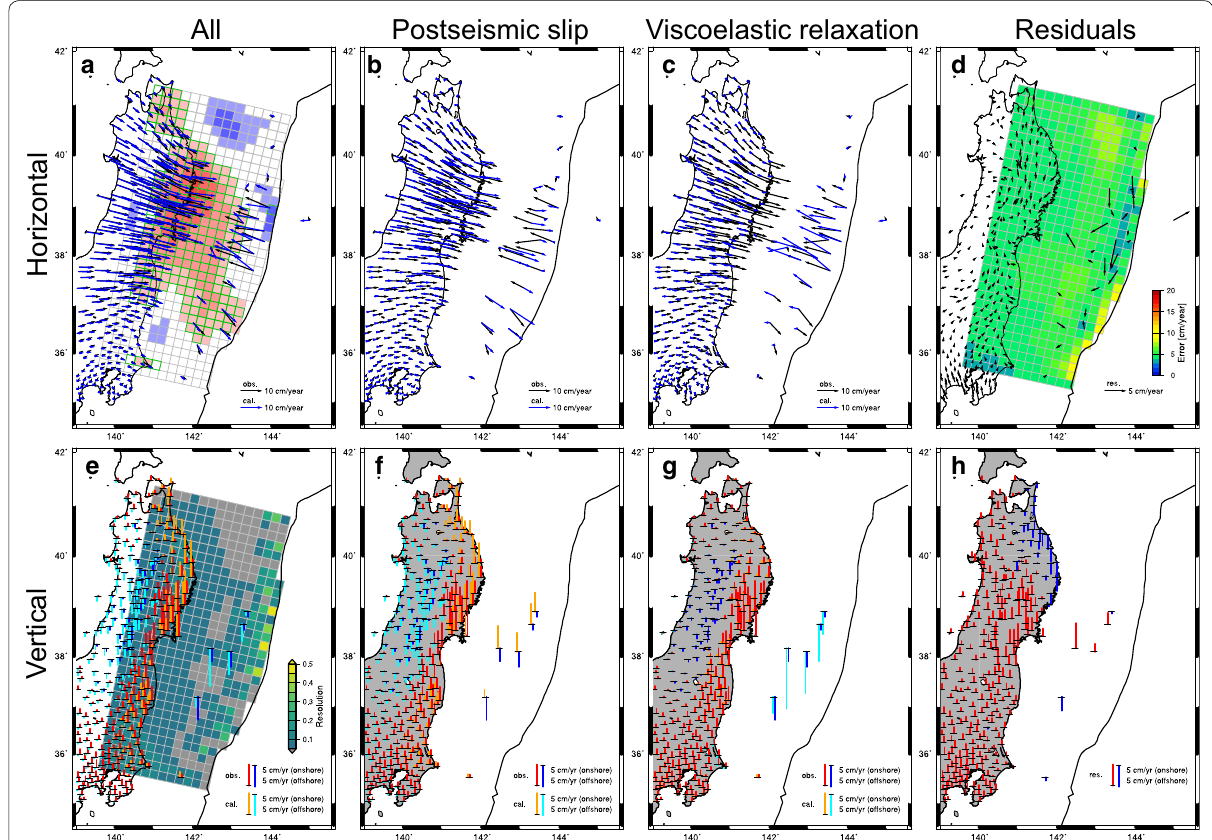
Fig. 13 Postseismic slip model by the viscoelastic inversion. Postseismic displacements and misfits in the viscoelastic model are shown in a – d (horizontal components) and in e – h (vertical component). Black vectors shown in the columns of “All”, “Postseismic Slip”, and “Viscoelastic Relaxation” represent the observed postseismic displacements. Black vectors shown in the columns of “Residuals” represent the misfits between the observation and the calculation. Blue vectors shown in the columns of “All” represent the calculated postseismic displacements. Blue vectors shown in the columns of “Postseismic Slip” and “Viscoelastic Relaxation” represent contributions of postseismic slip and viscoelastic relaxation of the calculated postseismic displacements, respectively. Red and blue bars shown in the columns of “All”, “Postseismic Slip”, and “Viscoelastic Relaxation” represent the observed postseismic displacements in uplift and subsidence directions, respectively. Red and blue bars shown in the column of “Residuals” represent the misfits. Orange and cyan bars represent the calculated postseismic displacements in uplift and subsidence directions, respectively, and they show contributions of the labeled postseismic deformation process. Colors of sub-faults in a , d , and e show postseismic slip,